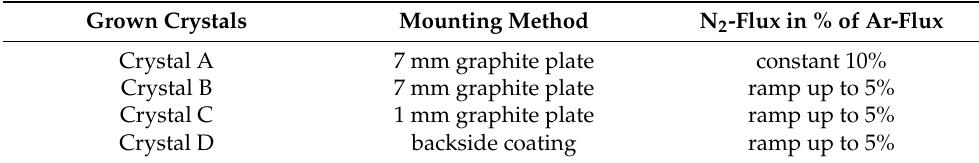
Table 1. Overview of the grown crystals and the variations of their growth